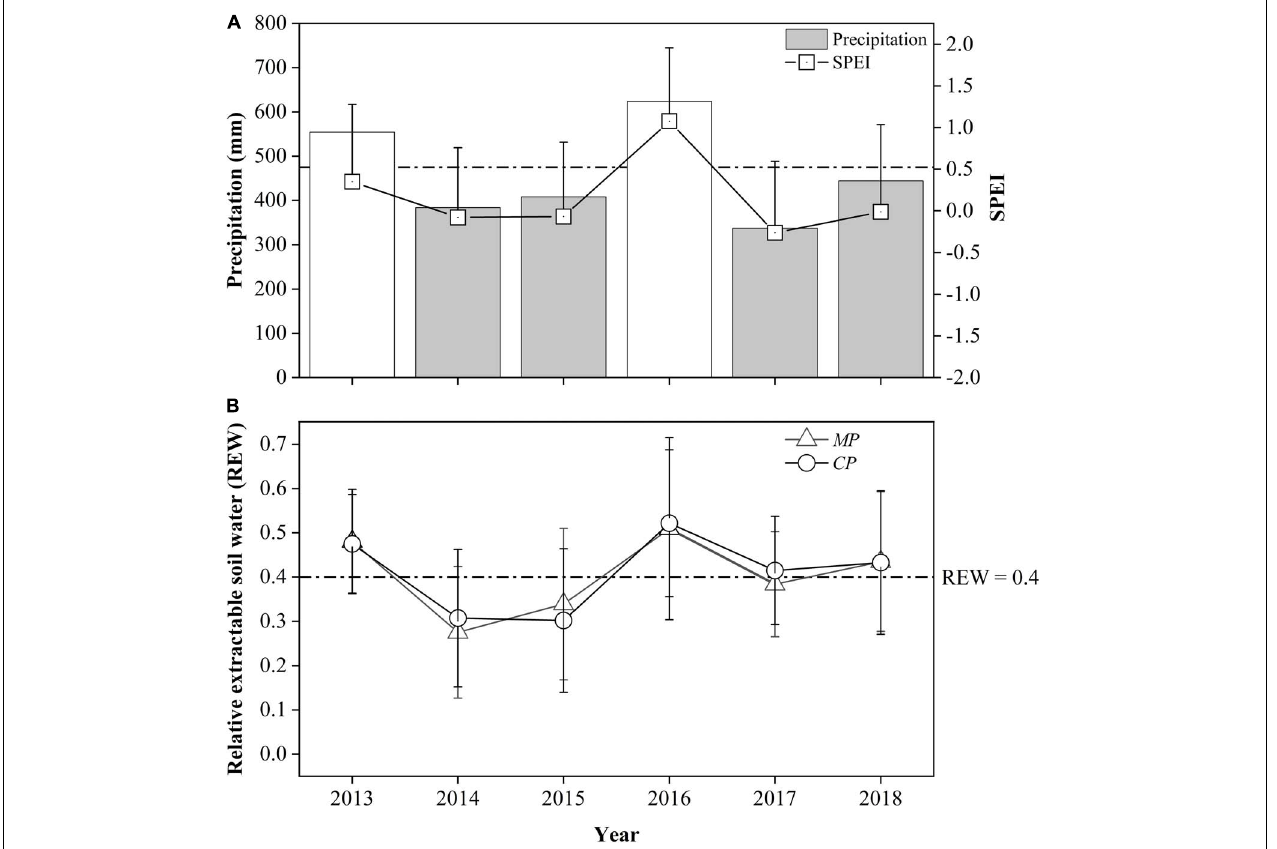
FIGURE 1 | Comparison of annual precipitation, the standardized precipitation evapotranspiration index (SPEI) at the study site (A) , and relative extractable soil water in two plots: Chinese pine ( CP ) plot and Mongolian Scots pine ( MP ) plot, (B) between years during the study period. The values in 2013 and 2016 are displayed with transparent color where there were no xylem sap flux measurements. The dotted horizontal lines represent the 30-year average precipitation (A) and the threshold value of soil water availability at REW = 0.4 (B) , respectively.